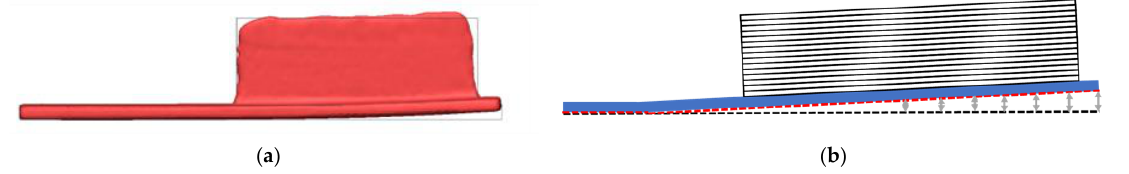
Figure 3. ( a ) Experimental optical 3D scanned data superimposed on reference CAD for Case 1; ( b ) Schematic showing the location for measurement of post-process line